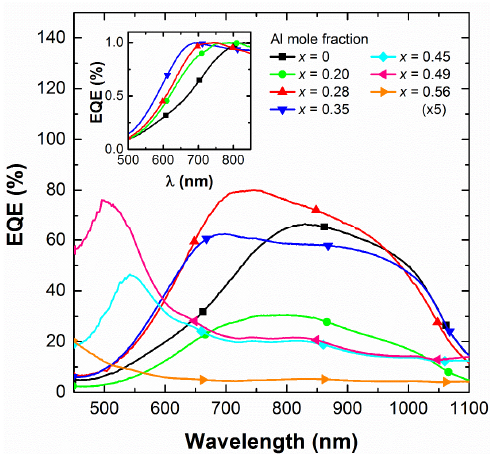
Figure 7. Influence of the Al mole fraction x on the EQE of the Al x In 1 − x N on Si (100) devices as a function of the wavelength. Inset: detail of the normalized EQE of devices with x ≤ 0.35.